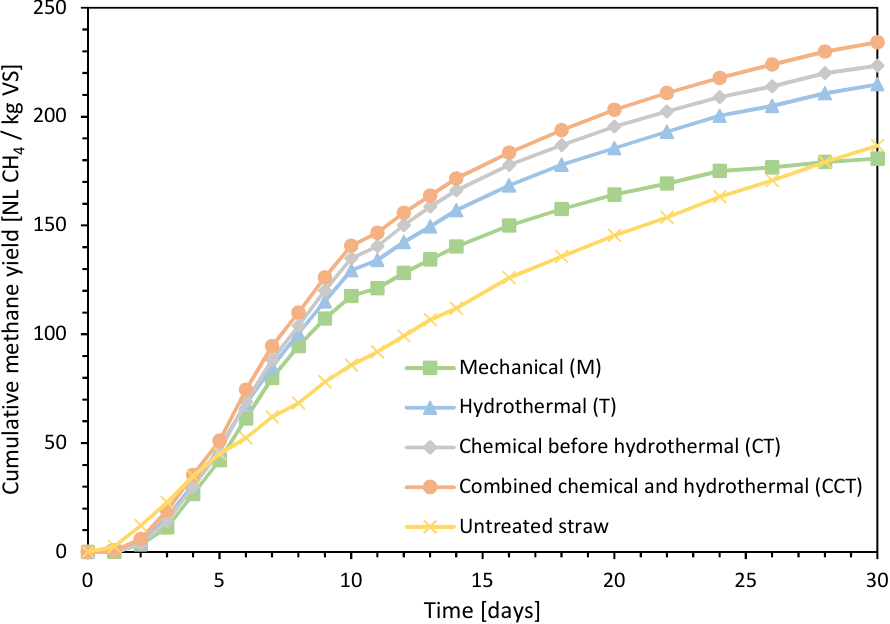
Figure 4. Cumulative methane yield of untreated straw, mechanical- (M), hydrothermal- (HT), Chemical- before hydrothermal (CT), combined chemical- and hydrothermal- (CCT) pre-treated straw.